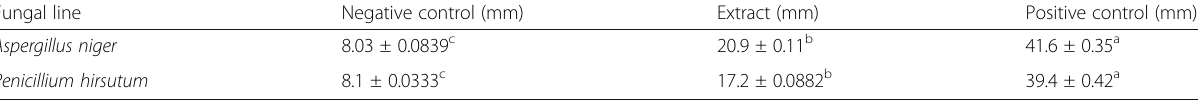
* Values represent means±SEM ; values in a row without a common superscript letter are statistically different ( P <0.05) as analysed by one-way ANOVA and the Tukey